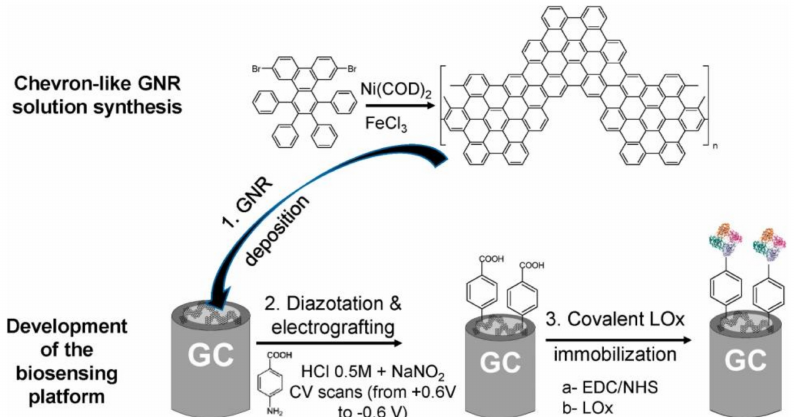
Figure 28. The creation of the lactate oxidase-based biosensor and the solution synthesis of the chevron − shaped GNR. (Reproduced from [559] with permission. Copyright 2022, Elsevier, Amster- dam, The Netherlands).